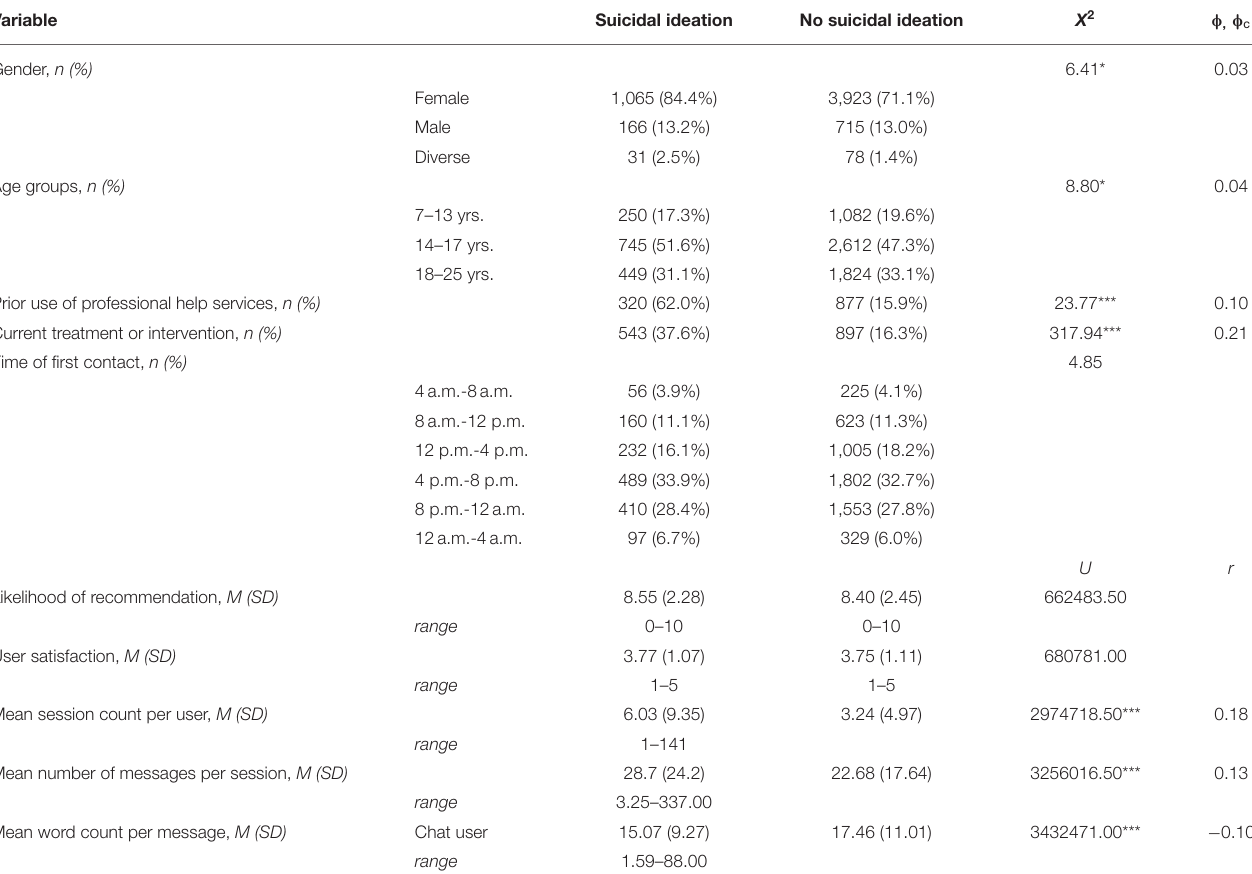
TABLE 1 | Sociodemographic data and utilization